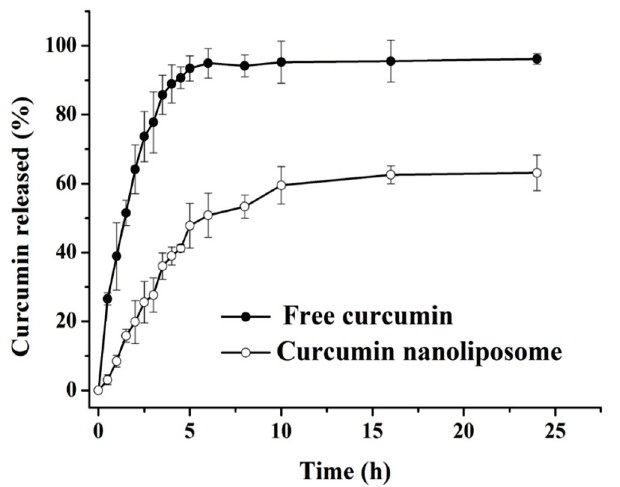
Figure 5. In vitro release of curcumin from free curcumin and curcumin